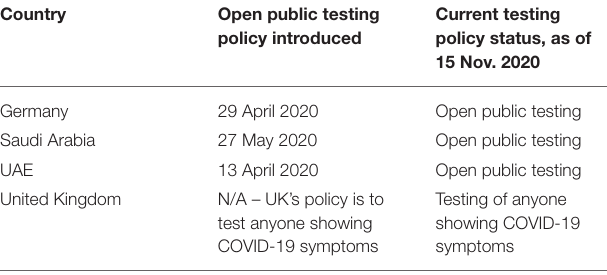
TABLE 2 | Testing Policies in Germany, Saudi Arabia, UAE, and United Kingdom. Country Open public testing policy